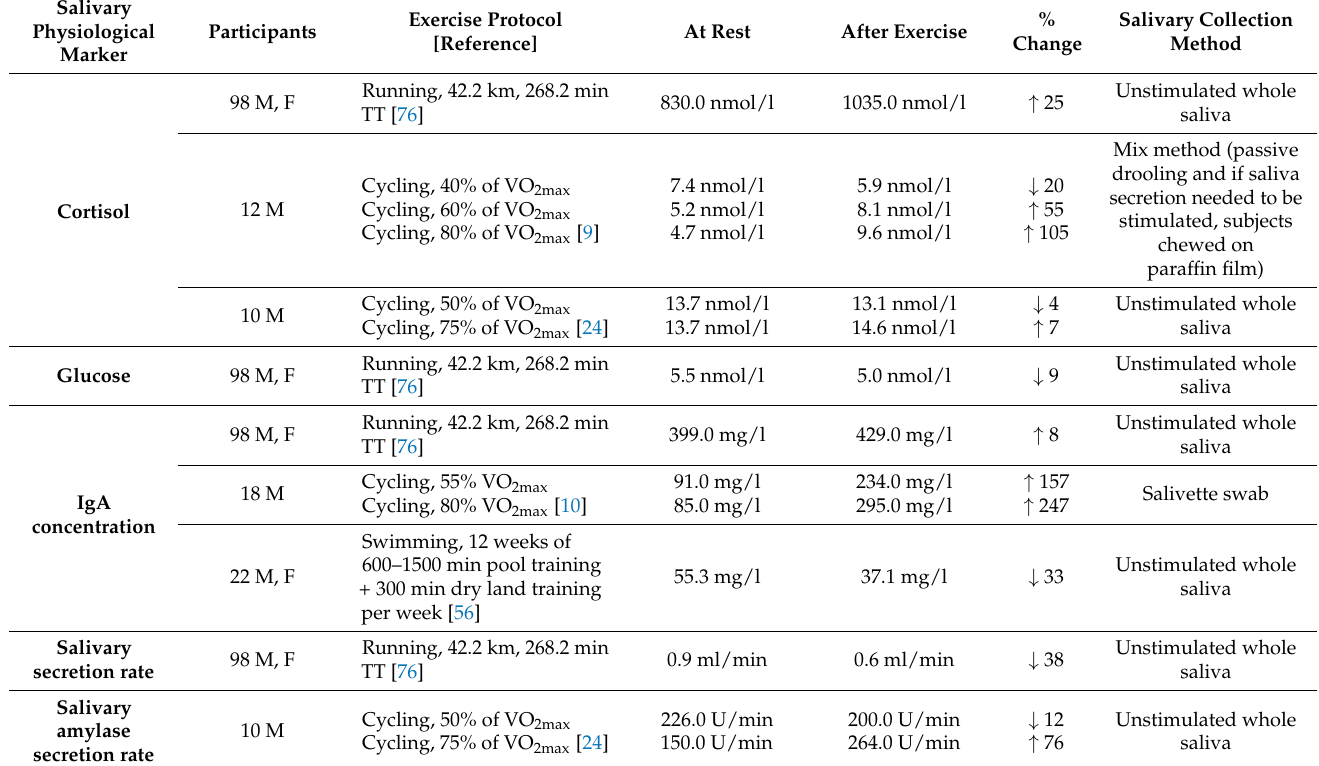
Table 4. Comparison of different salivary physiological markers at rest and after